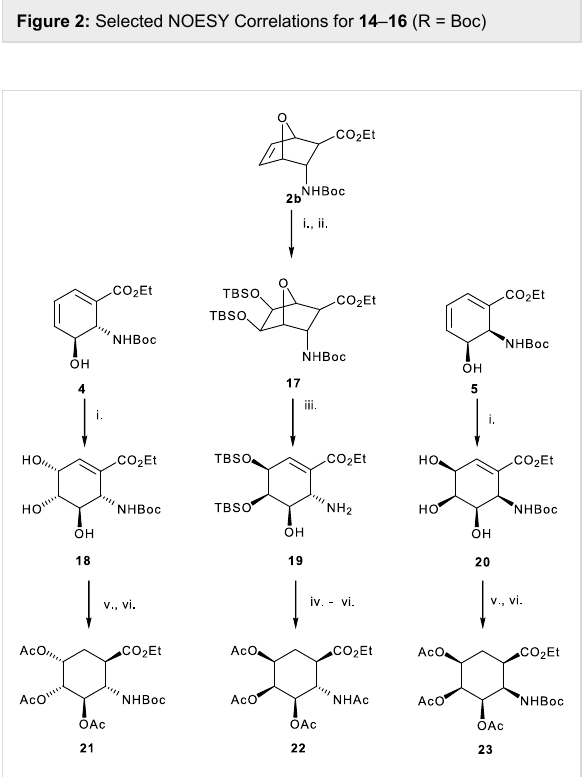
Scheme 4: Reagents: i. OsO 4 , Me 3 NO.H 2 O, acetone 18 78% from 4 ii. TBSCl, imidazole, CH 2 Cl 2 , 17 66% from 2b ; iii. LiHMDS, THF, -50-25 °C, 48%; iv. n Bu 4 NF, THF; v. Ac 2 O, pyridine; vi. H 2 , Pd-C, 21 67% from 18 , 22 51% from 19 , 23 74% from 5 .